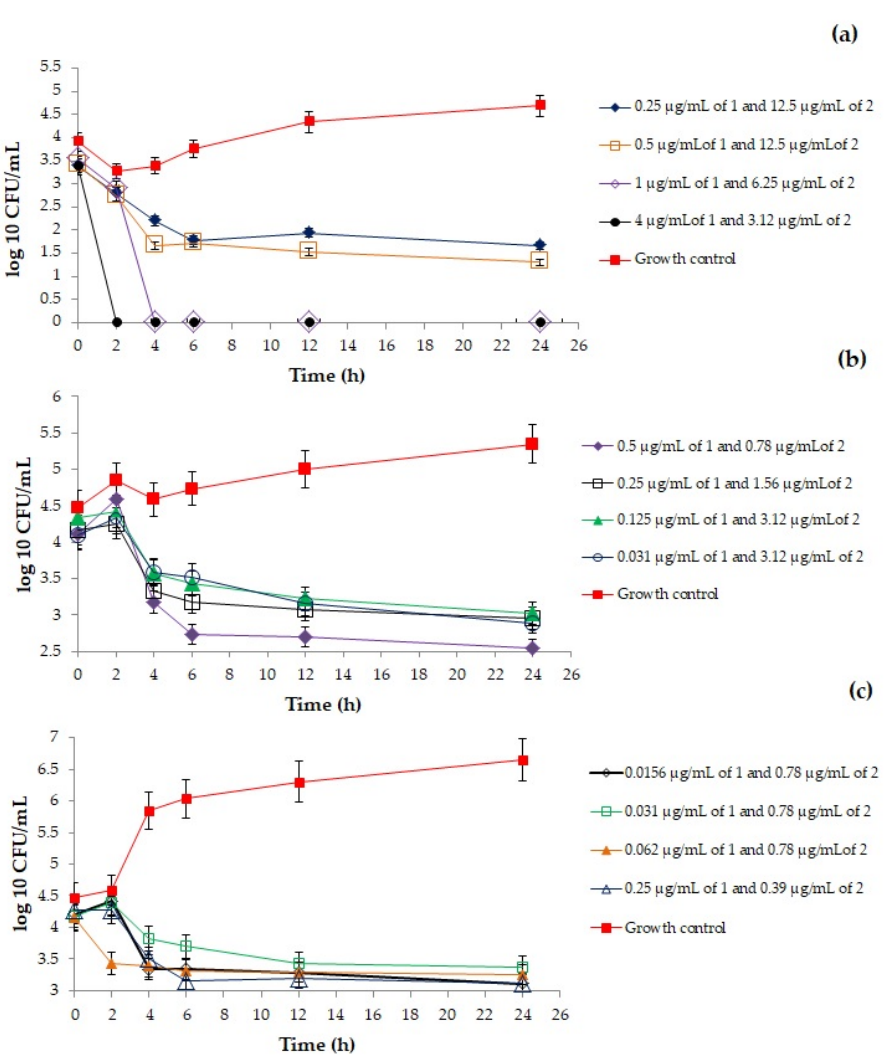
Figure 2. Time–kill curves of amphotericin B (1) and ent -hardwickiic acid (2) combinations against Candida strains: ( a ) C. albicans resistant strain; ( b ) C. albicans ATCC 10231; ( c ) C. krusei ATCC 6258. The error bars indicate standard deviations based on three replicates. Among the tested combinations of ent ‐ hardwickiic acid and amphotericin B concentrations against the reference strain of the C. albicans , the combination of 0.5